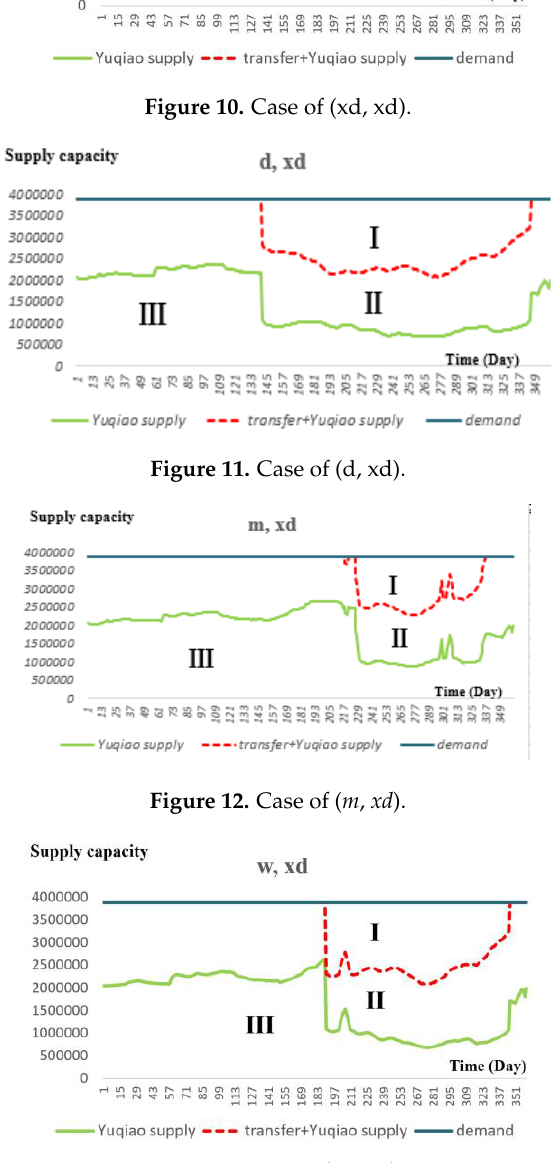
Figure 13. Case of ( w, xd ).